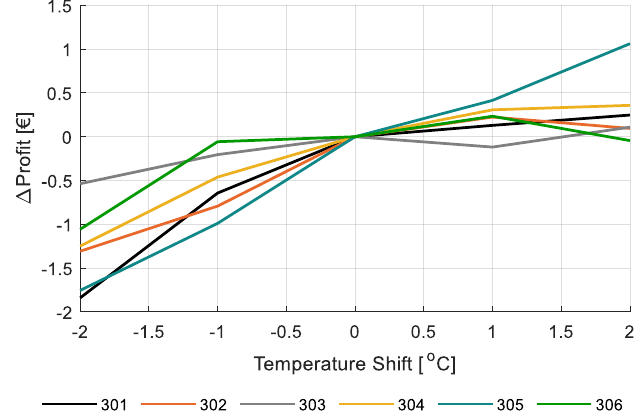
Figure 19. Change in simulated net profit (€/m 2 ) for varying CO 2 supply (kg/m 2 ) for the different greenhouse compartments (301–306).